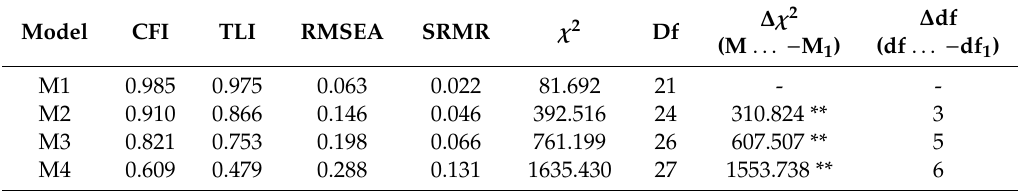
Table 2. Confirmatory factor analysis (CFA) and comparison of di ff erent measurement